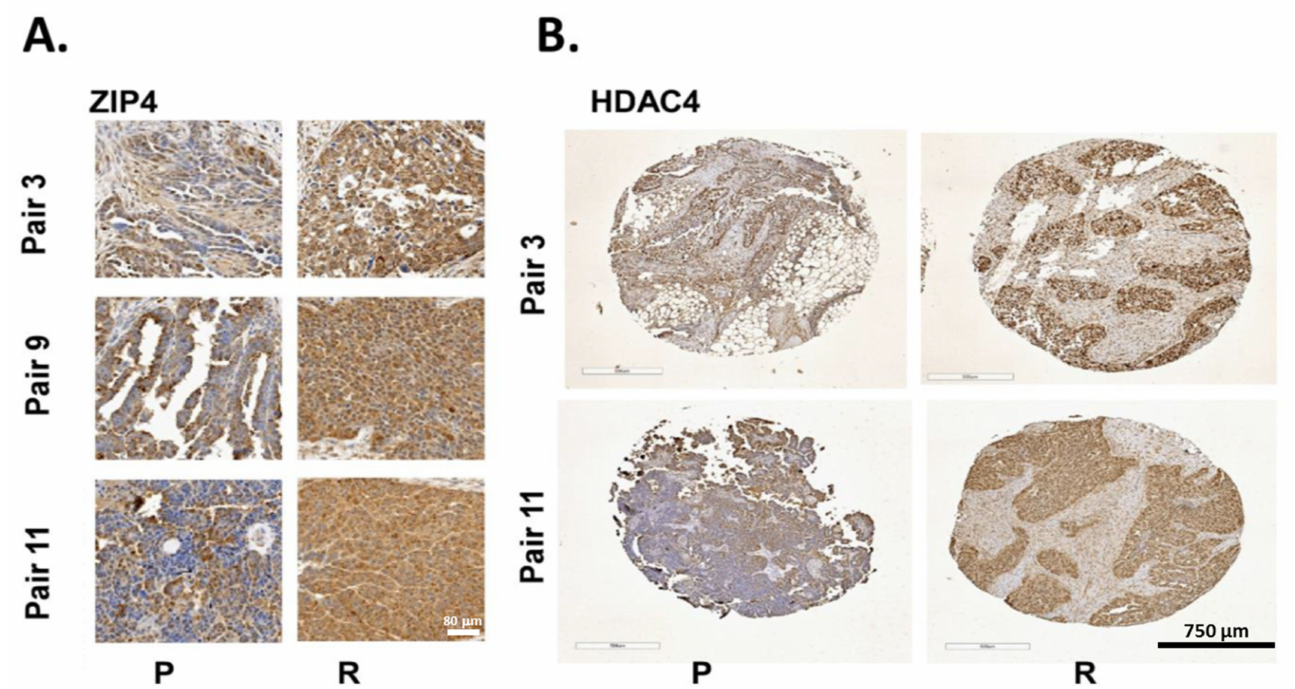
Figure 8. Co-overexpression of ZIP4 and HDAC4 in a subset of recurrent (R) vs. primary (P) human HGSOC. ( A ) ZIP4 was overexpressed in 3 of 10 recurrent (R) vs. primary (P) human HGSOC paired samples. ( B ). HDAC4 was overexpressed in 37% recurrent vs. primary paired samples tested, with two of these pairs also expressing high levels of